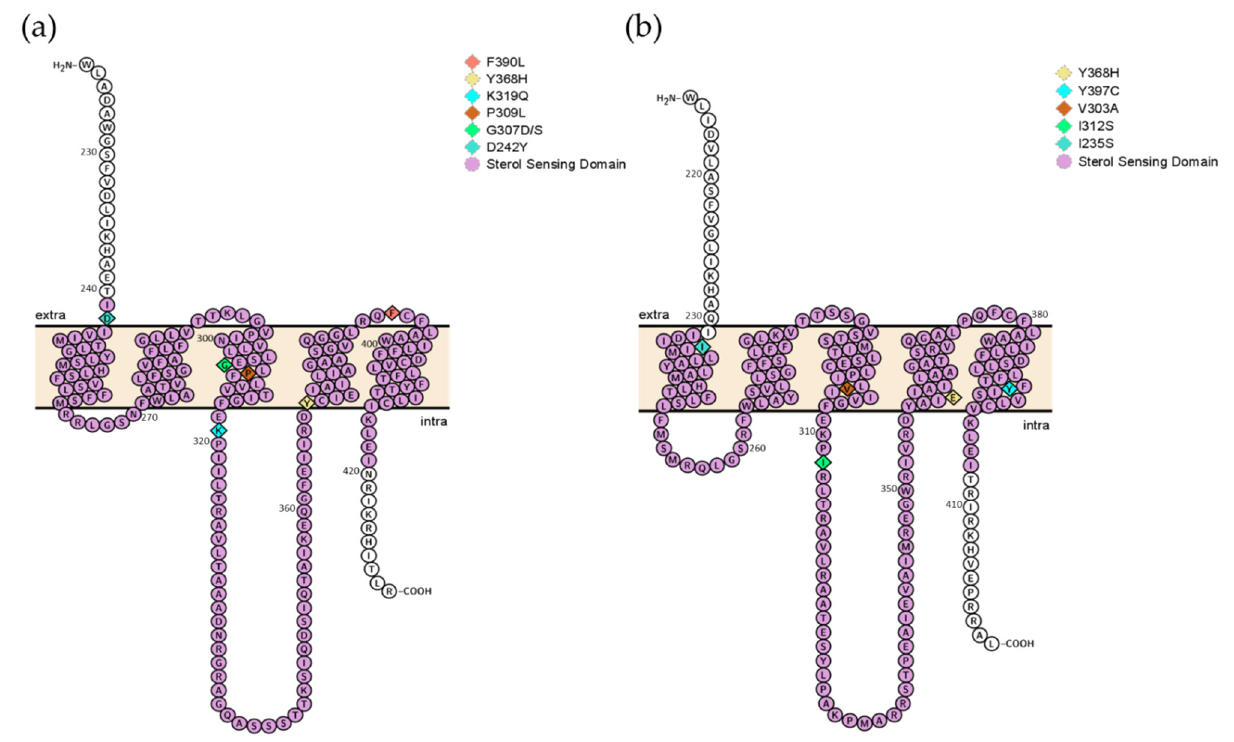
Figure 2. Secondary structure of the sterol sensing domain (SSD) regions of the proteins Hmg1 ( a ) and Hmg2 ( b ). Purple residues are indicating the SSD with the five transmembrane regions. The section of the Hmg1 and Hmg2 proteins represented here are truncated 18 amino acids before the SSD and 10 and 13, respectively, after. The amino acids marked in different colors and rhomboid shape represent the ones in which mutations have been described in this work. Table 5. A. fumigatus isogenic clinical isolates obtained from three independent patients with same MIC profile but different Hmg1 modifications.